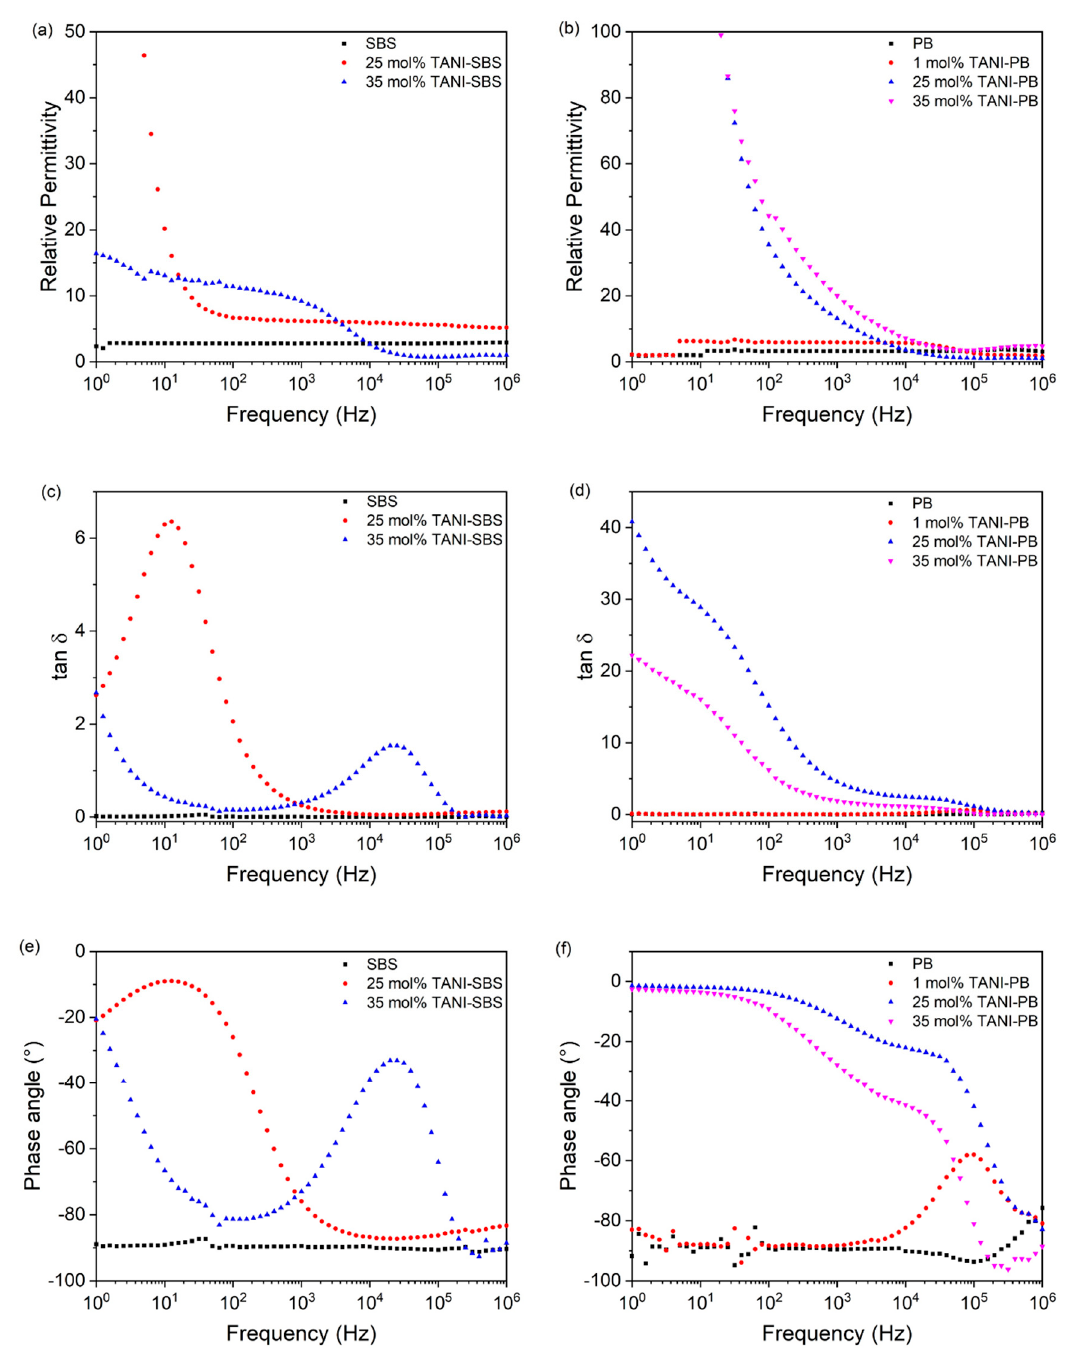
Figure 6. Dielectric properties of TANI modified SBS and PB.